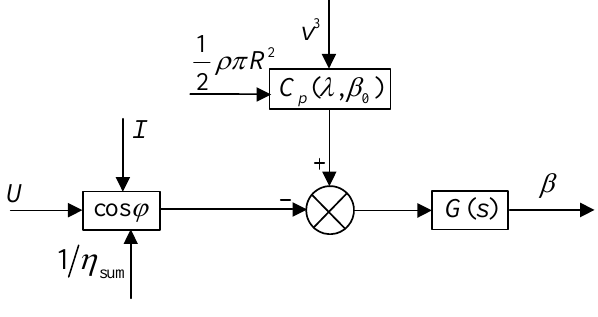
Figure 5. Pitch angle mathematical model.